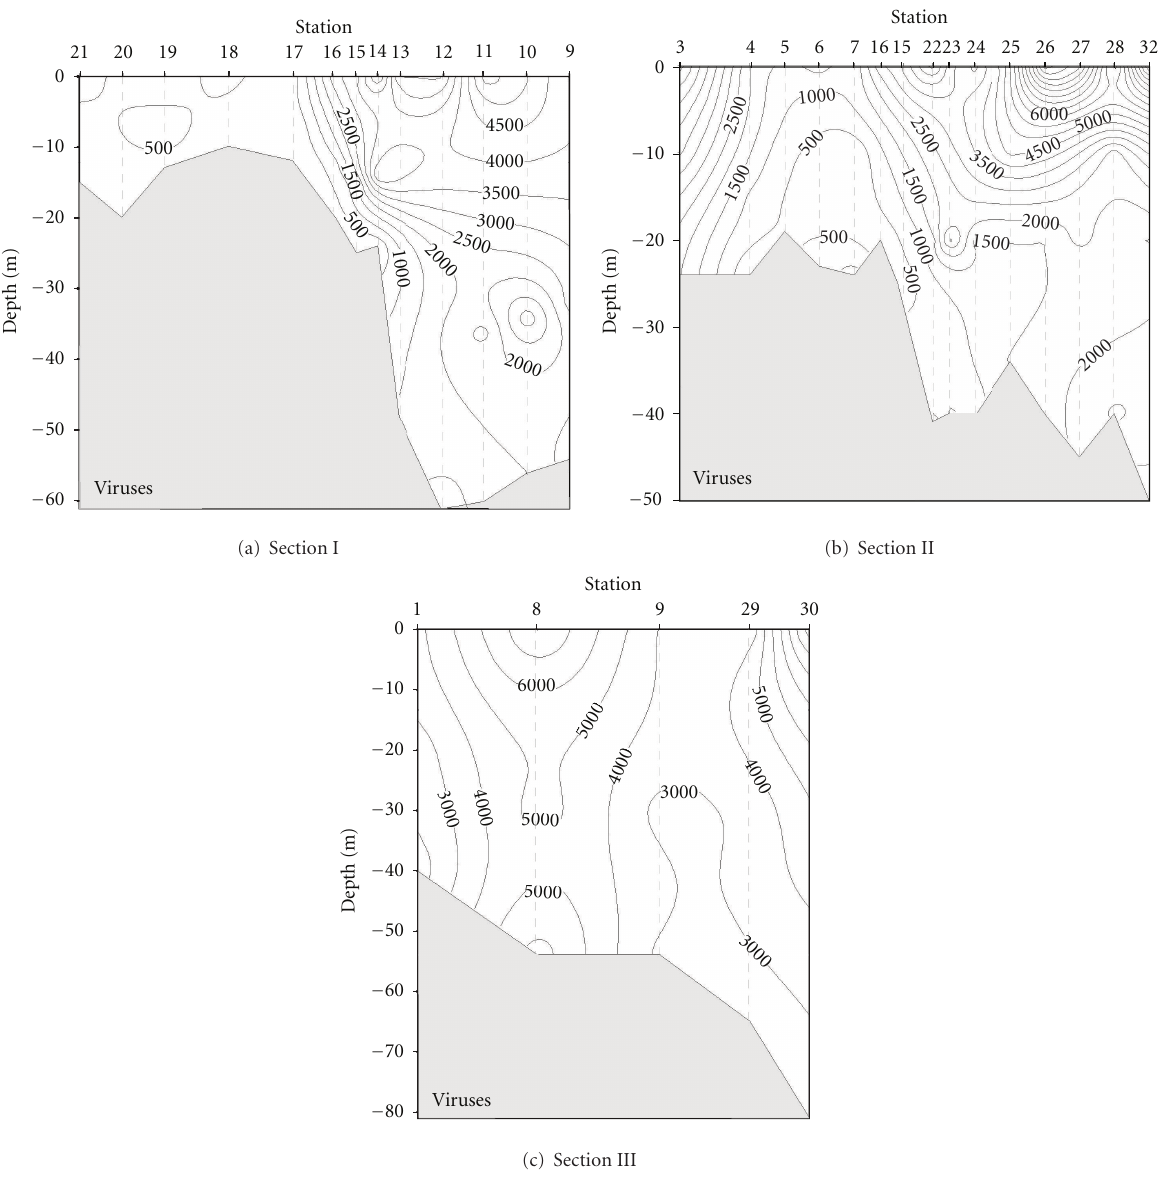
Figure 5: Spatial distribution of viruses ( × 10 6 particles L − 1 ) in the Changjiang estuary and its adjacent sea area in June